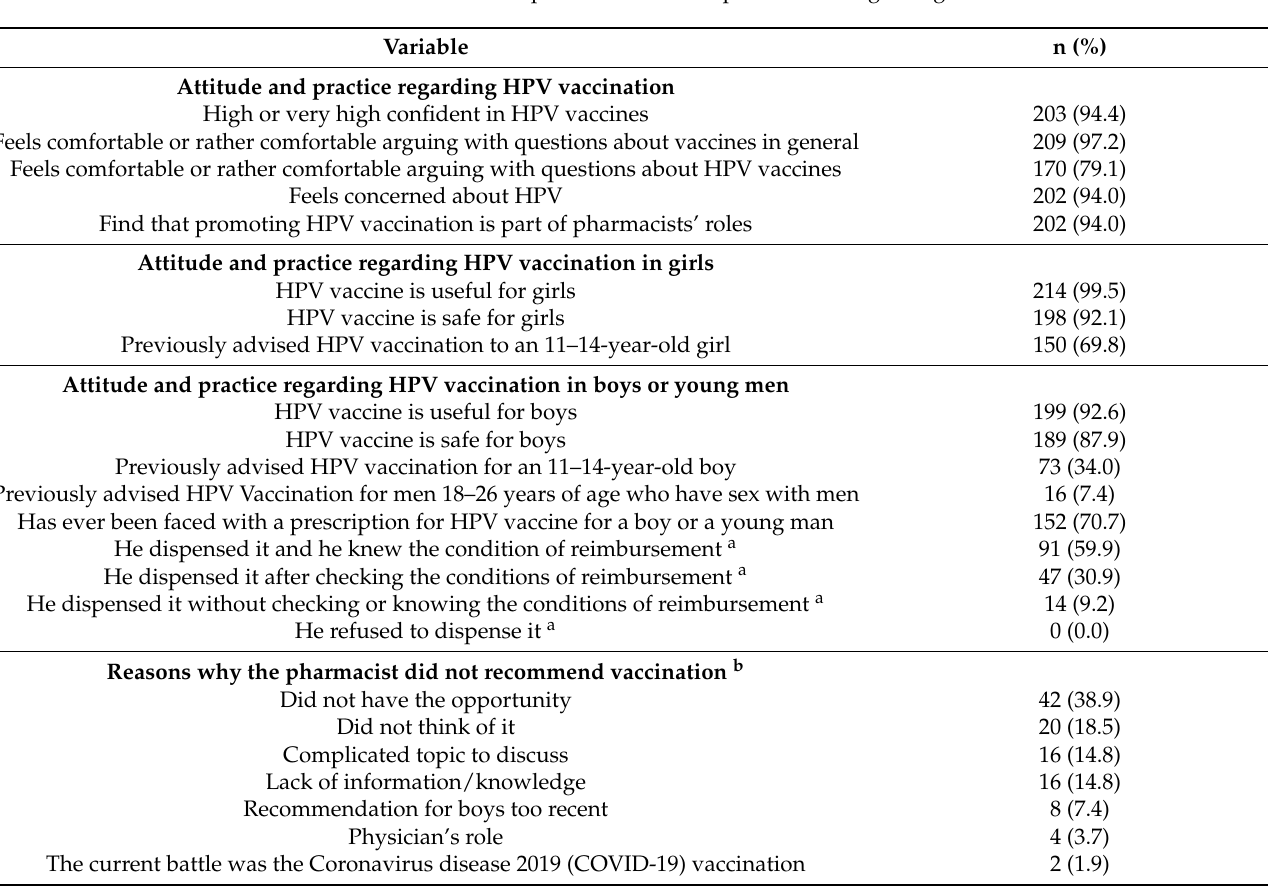
Table 3. Attitudes and practices of French pharmacists regarding HPV